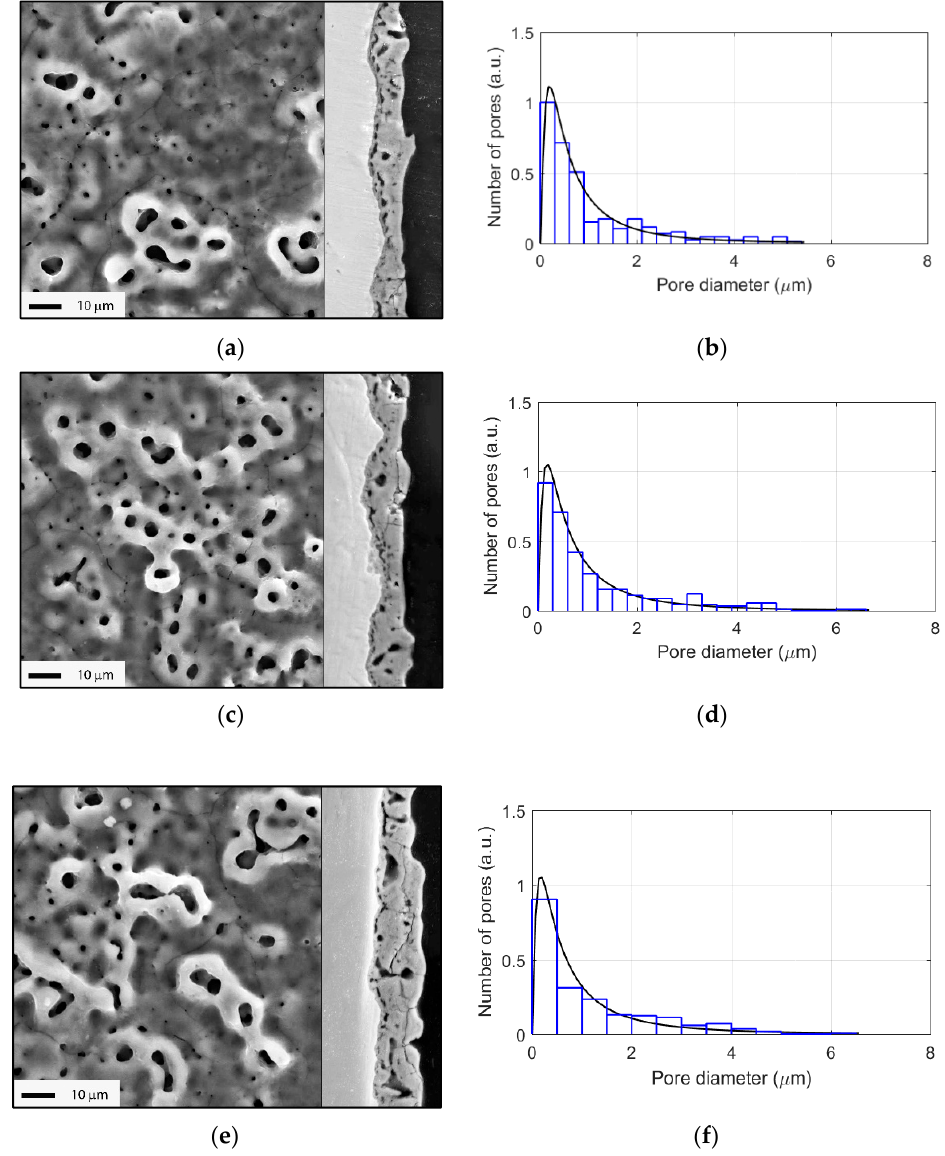
Figure 3. Surface morphology, coating cross-sections, and corresponding pore size distributions (with lognormal distribution fit) for the different PEO treatment times: ( a , b ) 180 s; ( c , d ) 240 s; ( e , f ) 300 s. Analysis of the numerical parameters characterizing the coatings is presented in Figure 5. The coating reached the thickness of 10 µ m by 120 s of the PEO, showing the growth rate of 5 µ m/min; further process was characterized by the rate of 0.5 µ m/min, and the coating reached a 12 µ m thickness by 300 s (Figure 5a). The surface roughness followed the coating thickness change: Ra rapidly grew from 0.1 to 1.0 µ m during 120 s, and then gradually reached 1.3 µ m by 300 s (Figure 5b). The peak height Rp and valley depth Rv also increased (Figure 5d); the Rp reached 5 µ m by 120 s and a further 8 µ m by 300 s. The maximal value depth was 4 µ m, which comprises one third of the coating